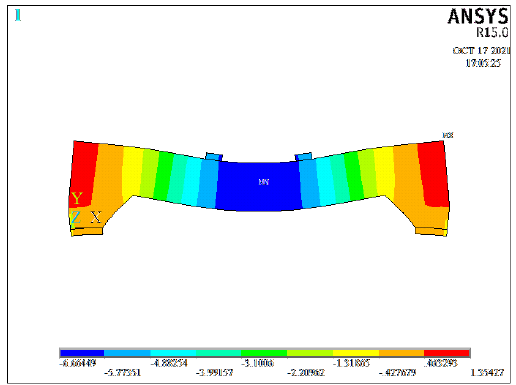
Figure 13. Contour of the deflection of the typical RC beam model B1 (solid).